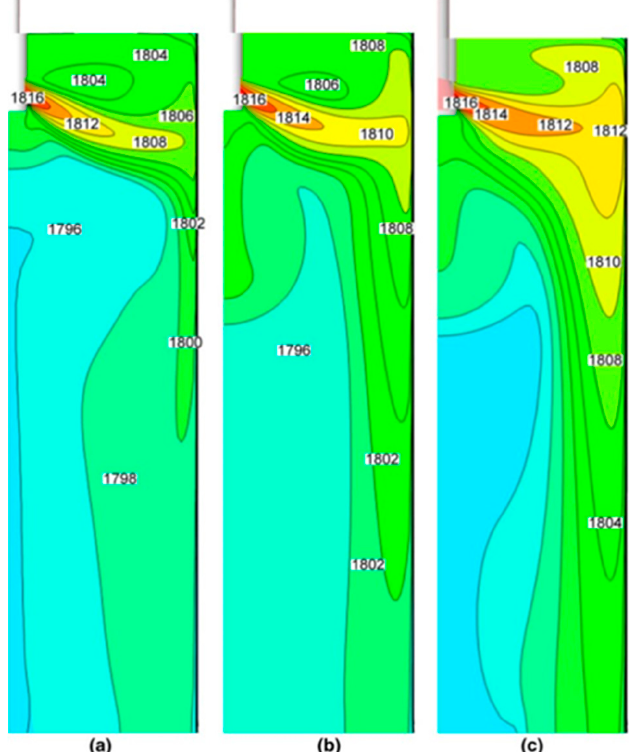
Figure 18. Temperature distribution in the mold with local EMBr field strength B 0 of ( a ) 0.0 T, ( b ) 0.2 T, and ( c ) 0.39 T [104].